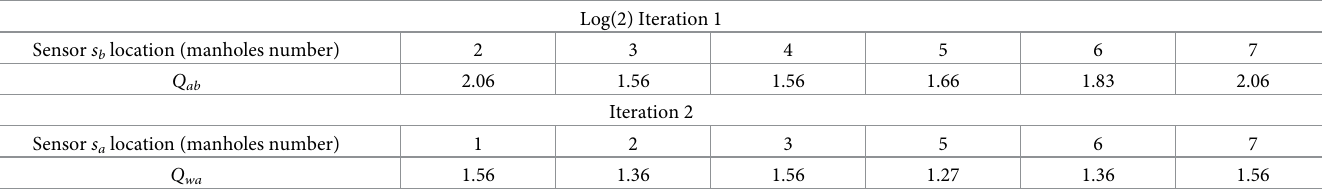
Table 1. Iterations 1 and 2 of the